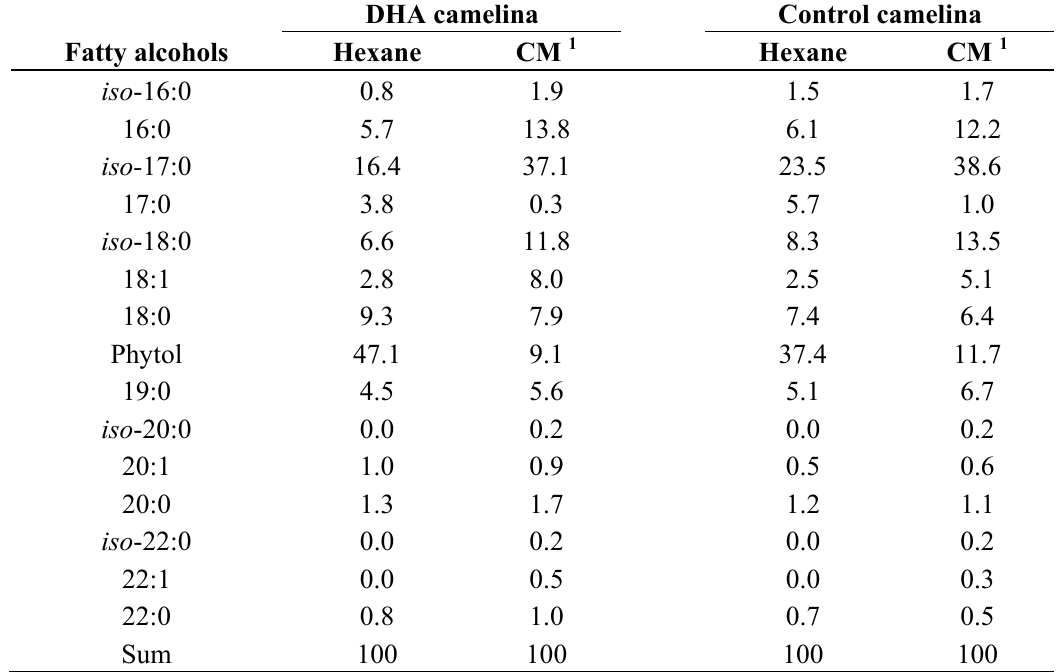
Table 6. Fatty alcohol composition (% of total sterols) of DHA- and control camelina. DHA camelina Control camelina Fatty alcohols Hexane CM 1